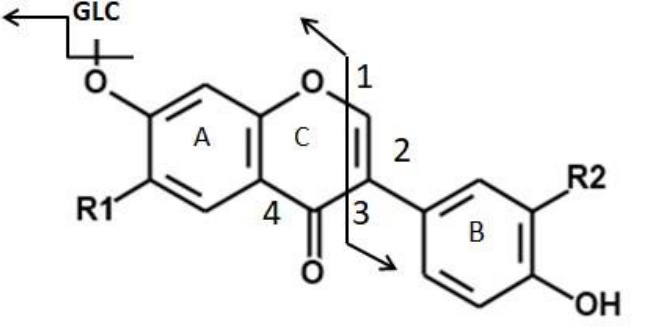
Figure 1. The proposed fragmentation model for flavonoids following the retro-Diels–Alder path to the C ring (after Gao et al., [91]).